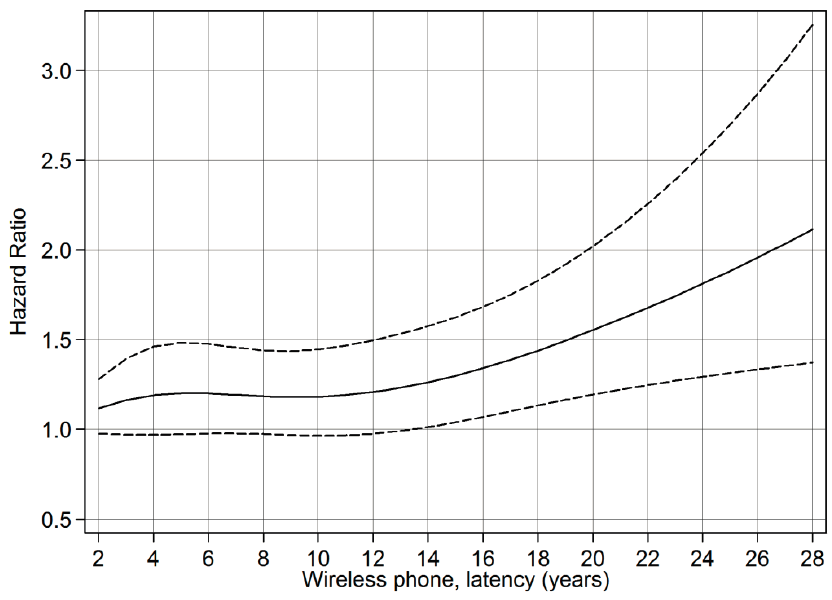
Figure 2. Restricted cubic spline plot of the relationship between latency of wireless phones and astrocytoma grade IV. The solid line indicates the HR estimate and the broken lines represent the 95% CI. Adjustment was made for age, gender, year of diagnosis, SEI-code, study, and age as a time-dependent